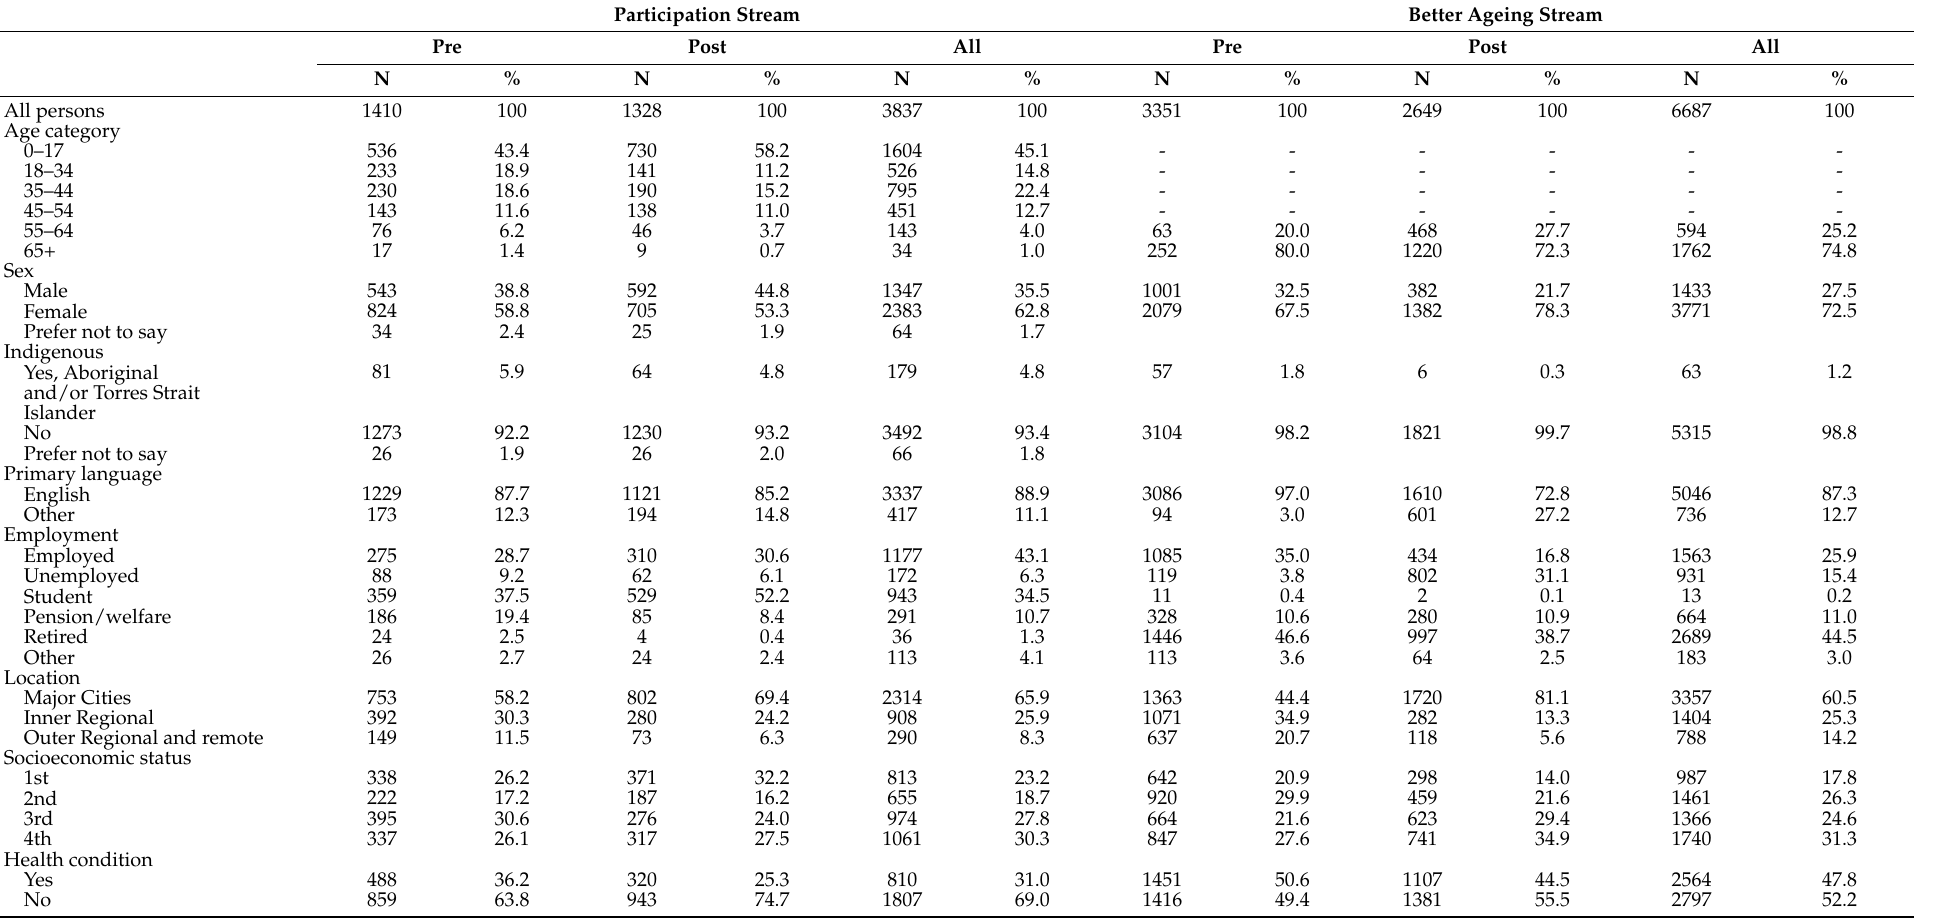
Table 2. Demographic characteristics of participants in the Participation and Better Ageing stream across